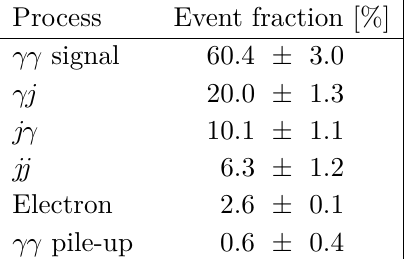
Table 2. Estimated composition of the signal region diphoton candidate samples, resulting from the inclusive sample fit. The uncertainties are fully dominated by the systematic uncertainties, which are discussed in section